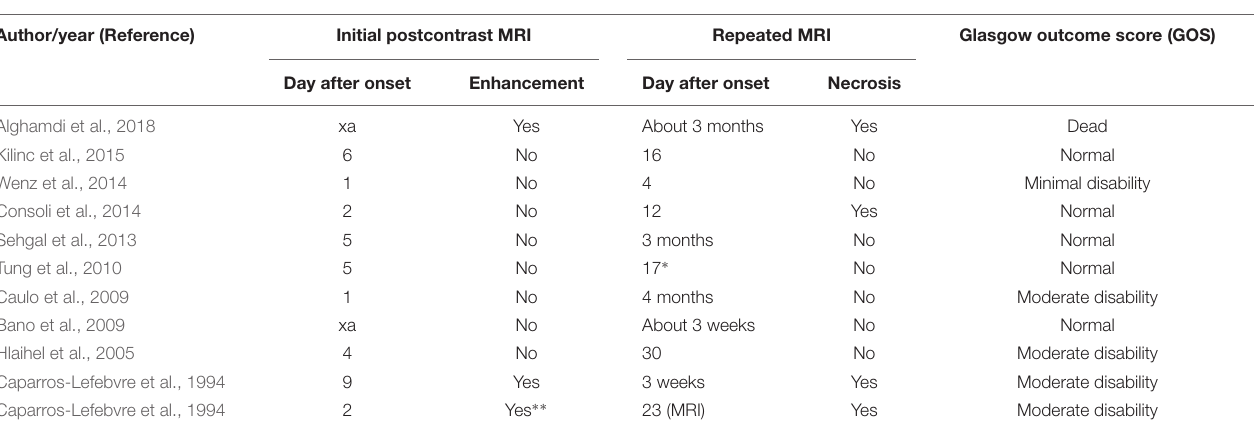
TABLE 1 | Neuroradiologic features in 10 reviewed cases of